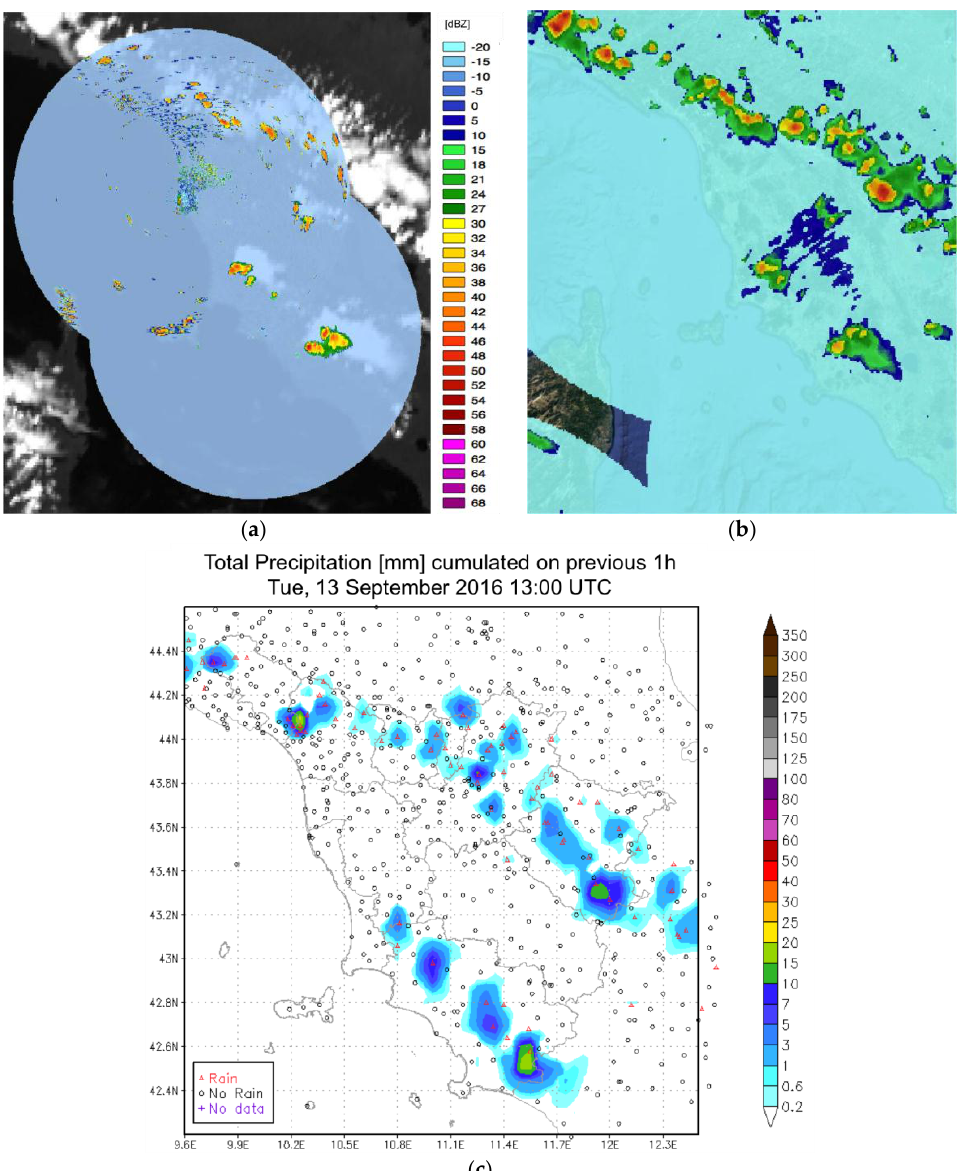
Figure 7. For the case study of 13 September 2016, 12:00 UTC: ( a ) Mosaic of VMI reflectivity for the regional X-band radar network, only for the Livorno and Castiglione della Pescaia radars, superimposed to the MSG (Meteosat second Generation) HRV (High Resolution Visible) channel; ( b ) Mosaic of VMI reflectivity for the Italian National weather radar network; ( c ) 1-h (12:00–13:00 UTC) cumulated precipitation obtained from measurements of the regional rain gauge